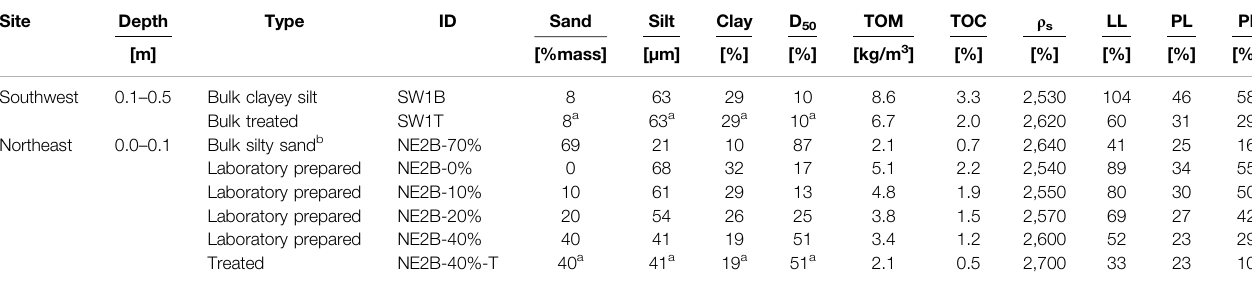
TABLE 1 | Sediment properties of all samples